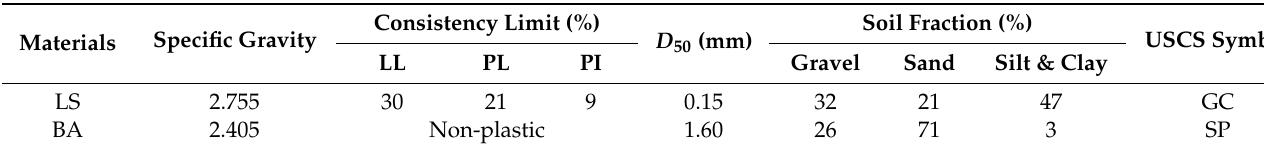
Table 1. Physical properties of the LS and BA.